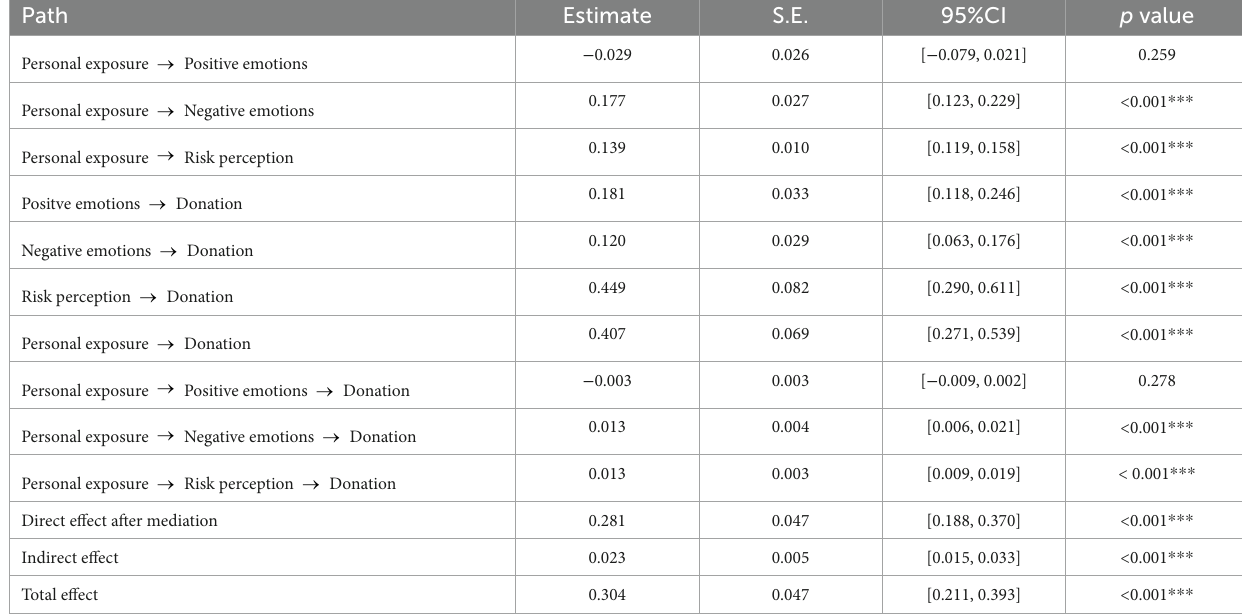
TABLE 4 The mediation analysis on the relationship between personal exposure and donation behavior with positive emotions, negative emotions, and risk perceptions as mediators.